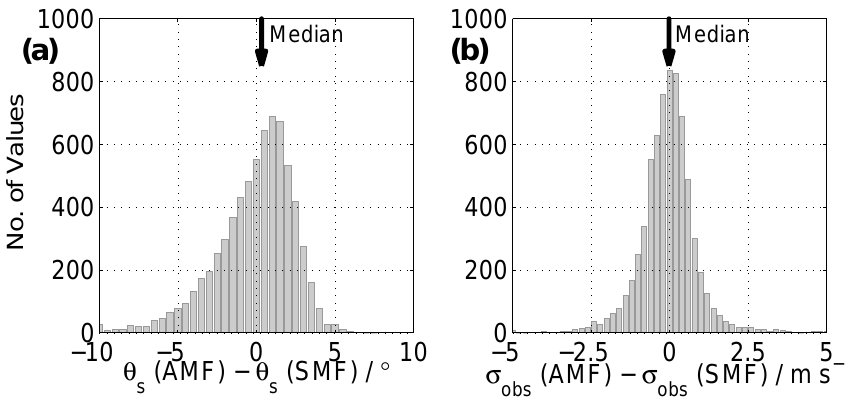
Fig. 8. Histogram of differences of the aspect sensitivity parameter (a) and the spectral width (b) between Andenes MF and Saura MF radars in the altitude range of 82 and 86km during July 2003.